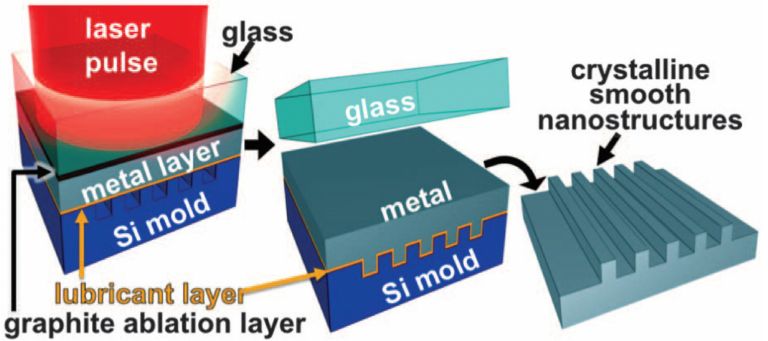
Figure 16. The schematic illustration of LSI [74].